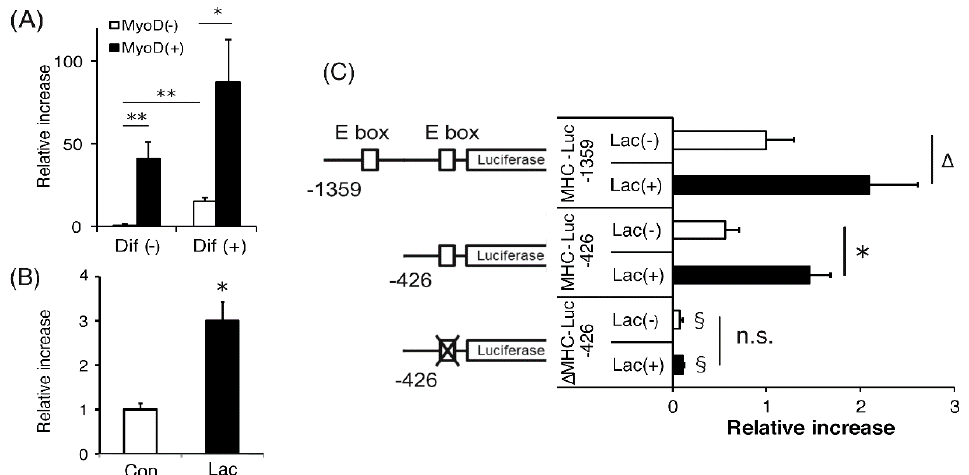
Figure 5. Lactate-induced increases in Myh4 promoter activity required specific E-box sequences. ( A ) Undi ff erentiated (Dif − ) or di ff erentiated (Dif+) C2C12 cells were cotransfected with a reporter vector containing 1.4 Kb of the Myh4 promoter region and a MyoD expression vector (pcDNA–MyoD; black bar) or its control (pcDNA3; white bar). ( B ) Differentiated C2C12 cells were transfected with a reporter vector containing the 1.4 Kb promoter region. At 24 h after transfection, the cells were incubated in the presence (Lac) or absence (Con) of 10 mM lactate for an additional 48 h. ( C ) Cells were then transfected with each deletion construct and then incubated in the presence (Lac+; black bar) or absence (Lac − ; white bar) of 10 mM lactate for an additional 48 h. Luciferase activity was measured and is expressed as the fold induction corrected for transfection efficiency, based on Renilla luciferase activity. Values are expressed as the fold change compared with the vehicle control, which was arbitrarily set to 1. n = 4 per group. Results are expressed as mean ± SE. Δ p < 0.1, * p < 0.05, ** p < 0.01, § p < 0.05, versus the reporter vector containing 1.4 Kb of the promoter region